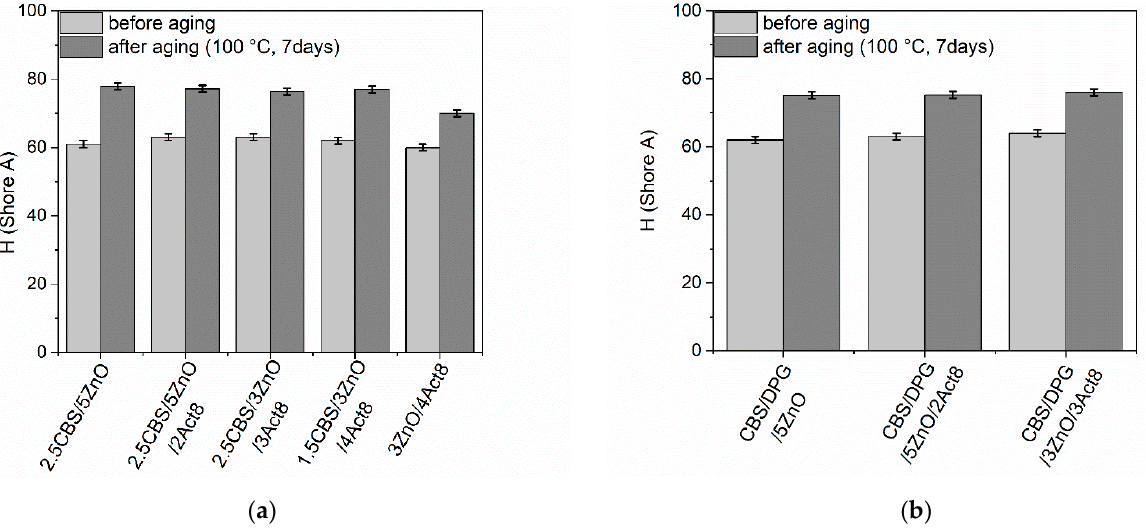
Figure 9. Influence of thermo-oxidative aging on the hardness of SBR vulcanizates containing: ( a ) CBS; ( b ) CBS and DPG. ( a ) CBS; ( b ) CBS and